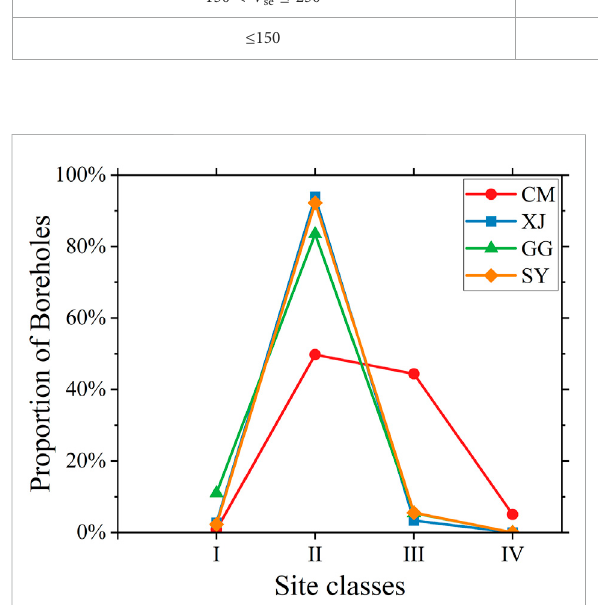
FIGURE 4 Scatter plots of V se versus H for sites in CM, XJ, GG, and SY, together with histograms of V se and H values. The polygonal lines distinguish the ranges of V se and H for different site classes as de fi ned by the Chinese seismic